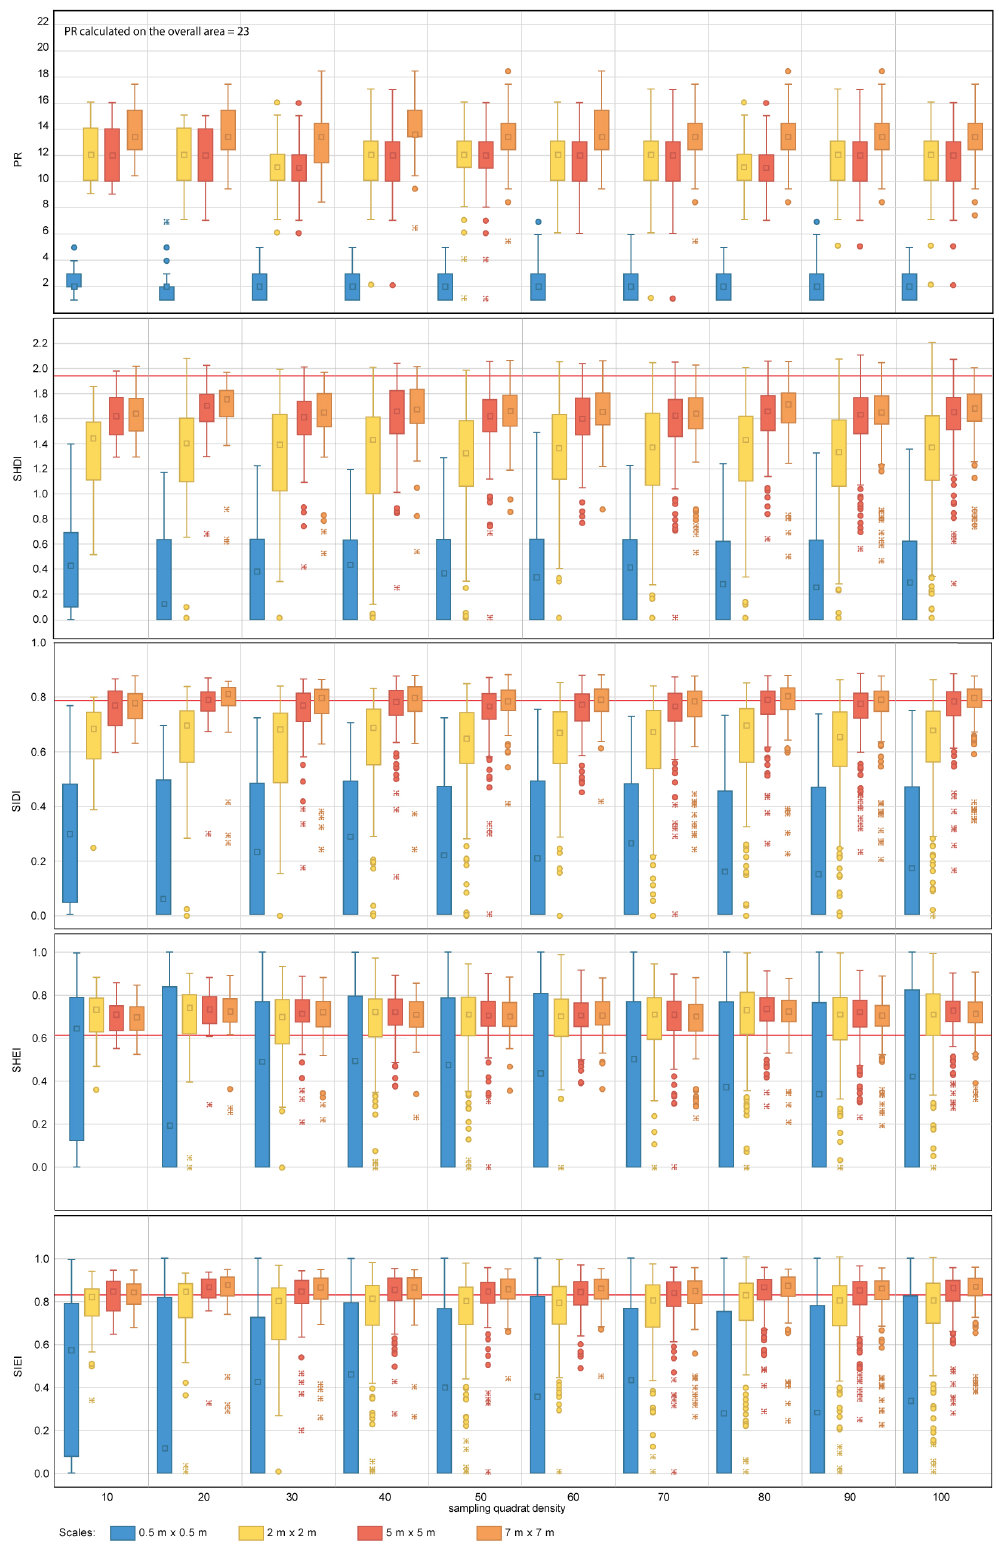
Figure 8. Diversity metric values obtained for the nested sampling strategy for the range of scales and quadrat densities considered. The red horizontal line indicates the metric value obtained for the total area mapped. PR, SHDI, SIDI, SHEI and SIEI stand for Patch Richness, Shannon’s Diversity Index, Simpson’s Diversity index, Shannon’s Evenness Index and Simpson’s Evenness Index, respectively. The boxplots show the first, second (median), third and fourth quartiles. Circles and crosses indicate outliers and extreme values,